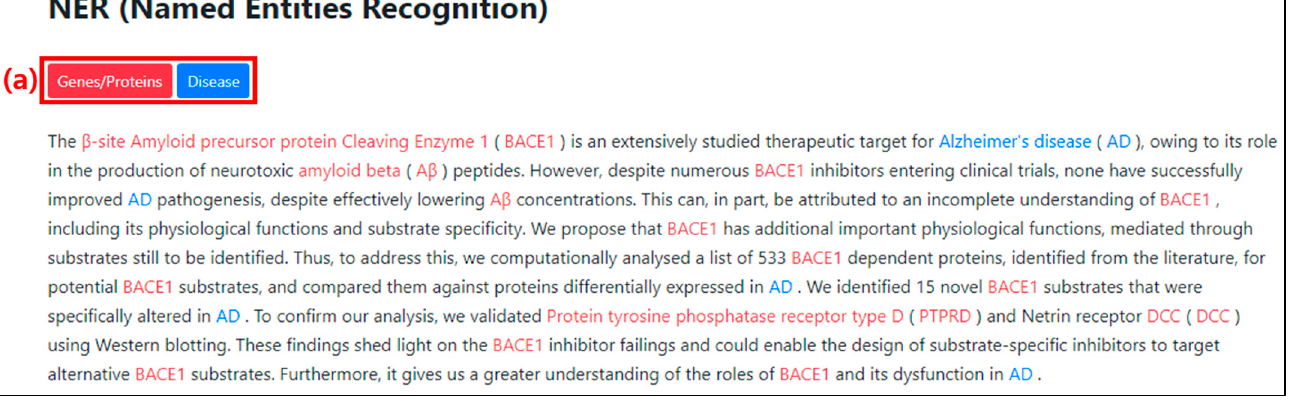
Figure 9. NER result screen on web page after PMID input. (a) It is an interface to indicate the type and color of the result category from the NER.